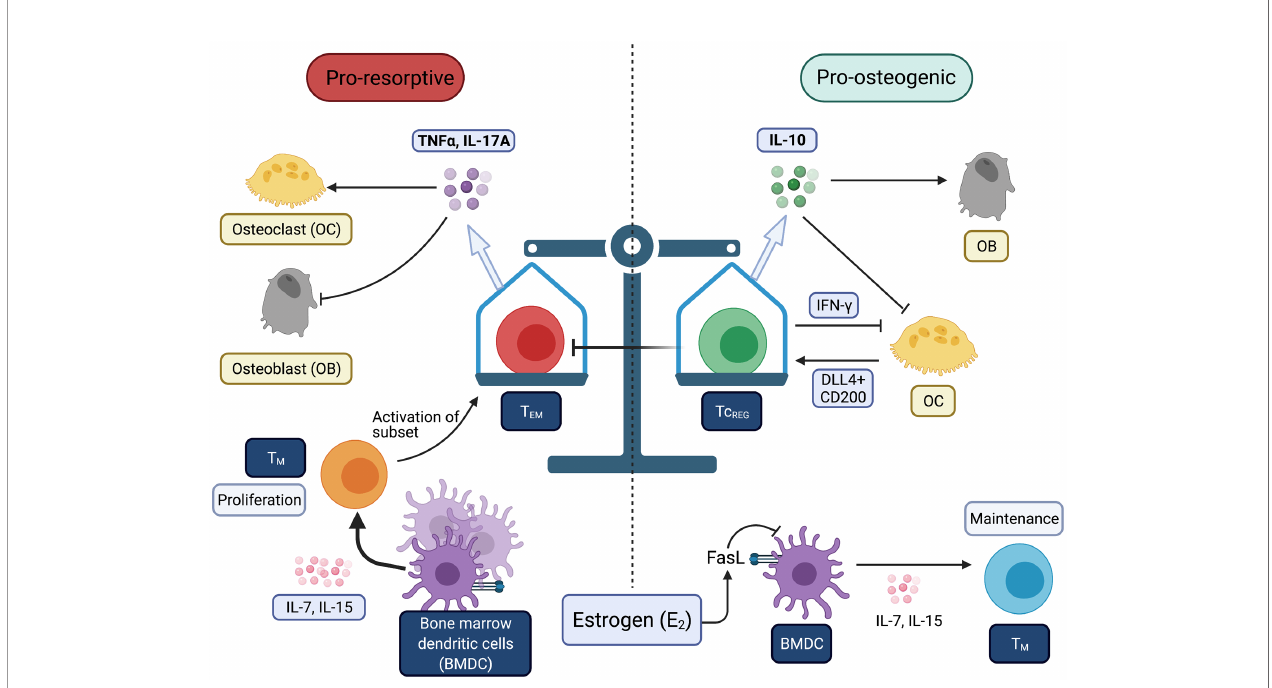
FIGURE 1 | Balance between immunogenic and tolergenic states is linked with resorptive and osteogenic states of the bone. Chronic in fl ammation may be derived by increases in effector T-cells (T EFF ) and effector memory T-cells (T EM ). Bone is very sensitive to TNF a and IL-17A produced by T-cells. Estrogen (E 2 ) prevents the conversion of T M to T EM . Tolerogenic T-cells (i.e., T REG and Tc REG ) promote bone formation through direct and indirect mechanisms. All Figures were created with